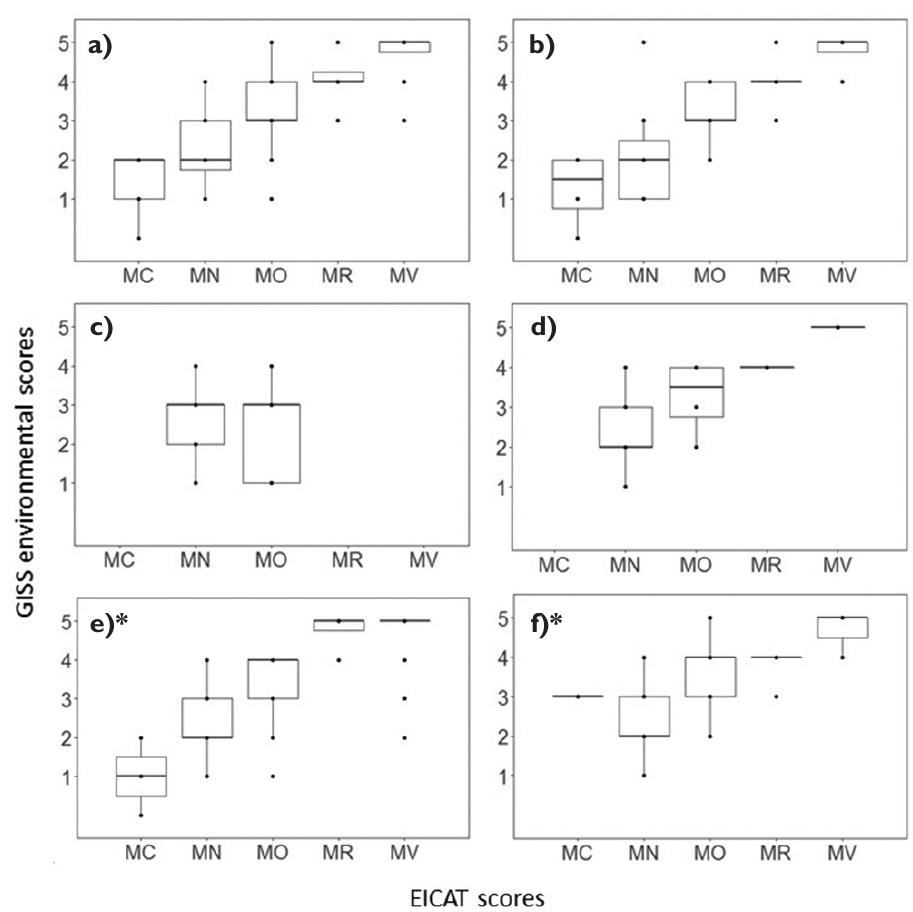
Figure 2. Relationship between GISS environmental and EICAT scores given for comparable mecha- nisms, including: a competition b herbivory c hybridisation d disease e predation and f ecosystems. We used each publication as a separate impact record for this analysis. Significantly different scores for schemes are indicated using